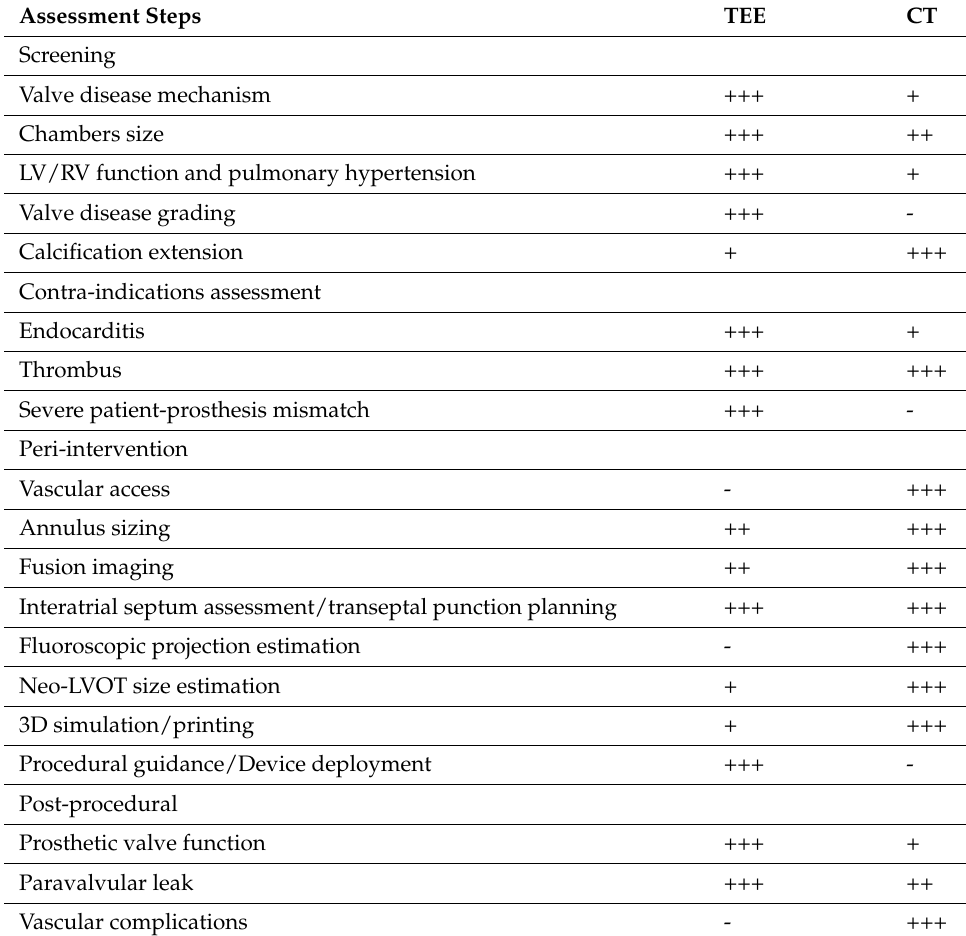
Table 1. Suggested assessment steps for TMVR with preferred modalities. Assessment